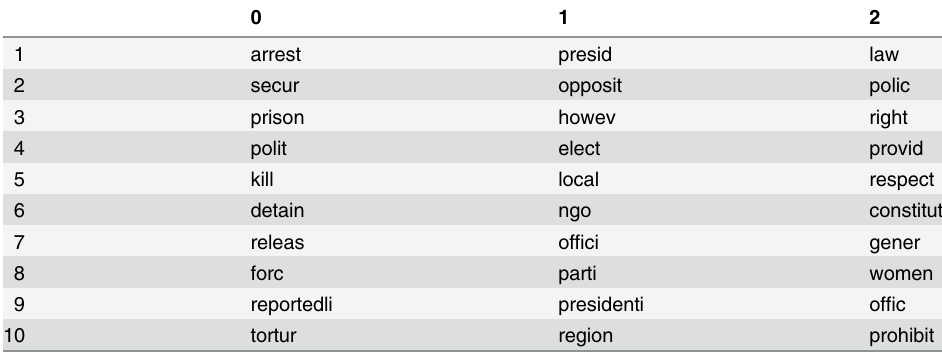
Table 6. Ten most important words for the CIRI Political Imprisonment variable.